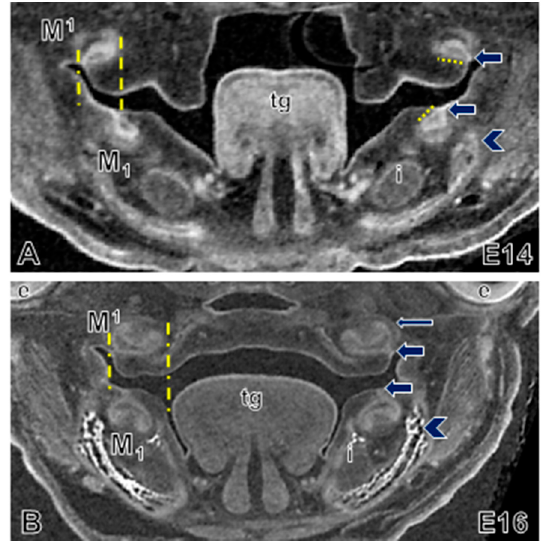
Figure 4. Molar morphogenesis in embryonic wild-type mouse. Coronal view of embryos aged ( A ) E14 and ( B ) E16 showing the lingual tilting (short yellow dotted line, right) of upper and lower M1 organs, and the buccal location of the upper M1 organs at E14. The M1 dental stalks (yellow dashed lines, left, and arrows, right) of the upper molar organs are laterally positioned relative to lower molar organs. By E16 the upper molar organs are wider than the lower organs (yellow dashed lines, left). Mineralizing dentary bone (bright white, arrowhead) is located buccal to the molar and the incisor (i). Long thin arrow ( B ) points to the wall of the dental follicle (crypt). Abbreviations: e, eye; i, incisor; t, tongue.